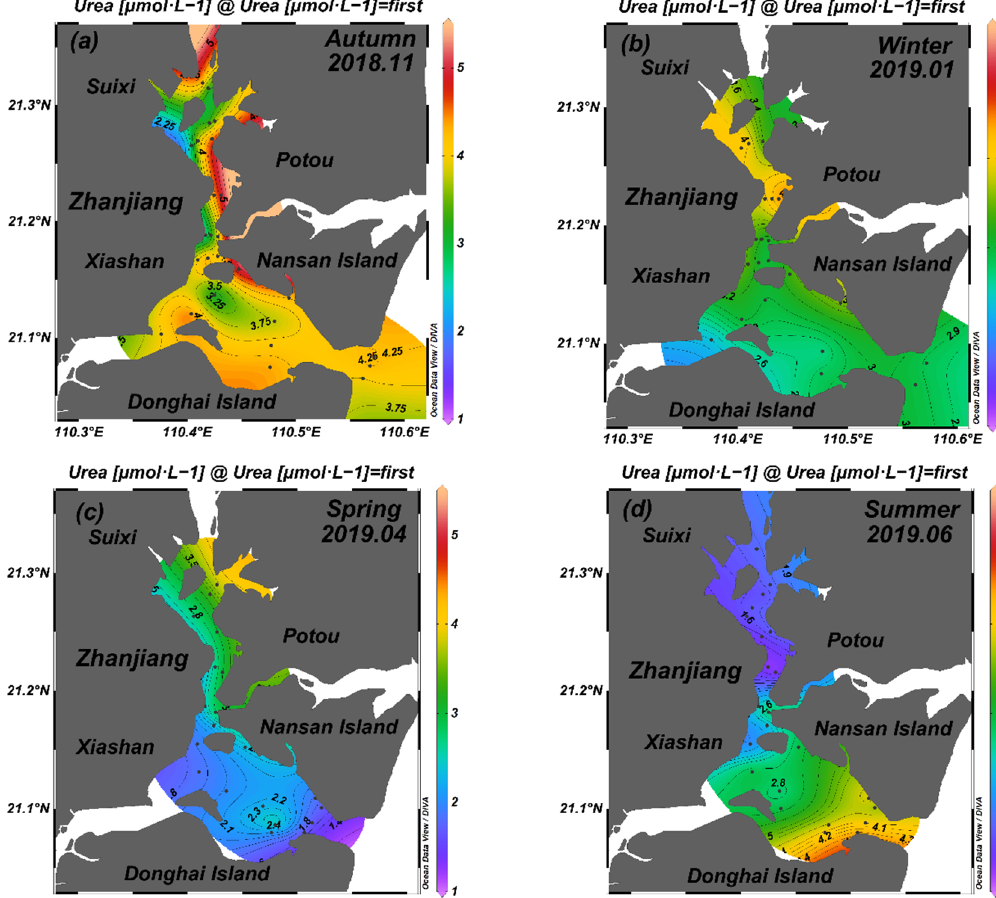
Figure 2. The spatiotemporal distribution of urea in seawater of the ZJB in different seasons.